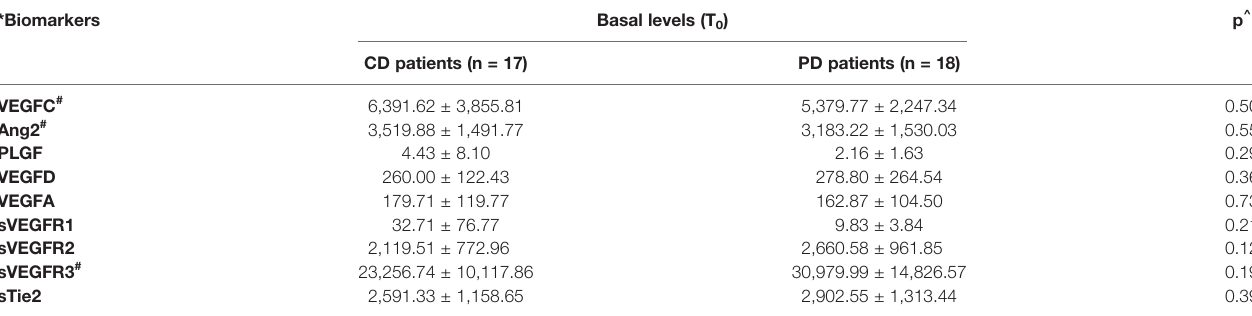
TABLE 2 | Differences between serum basal levels of biomarkers in control disease group and progression disease group.